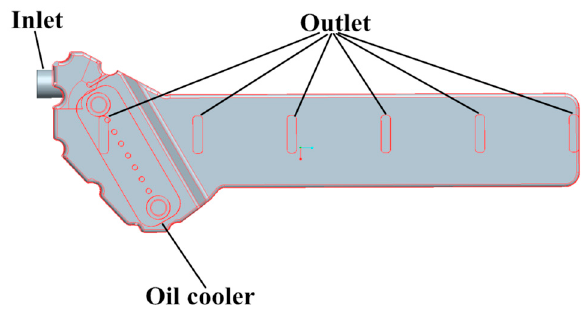
Figure 10. The computational fluid dynamics (CFD) model of the oil cooling system.